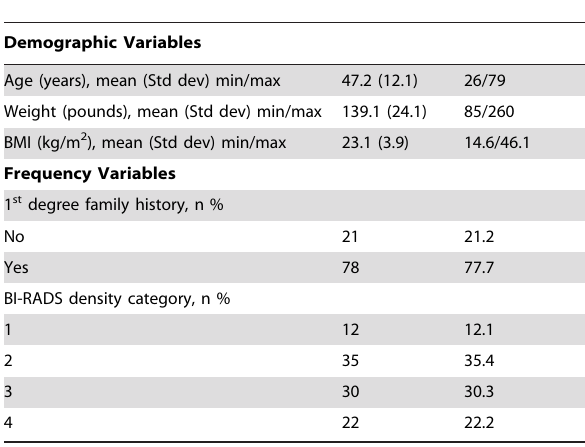
Table 1. Description of population characteristics.